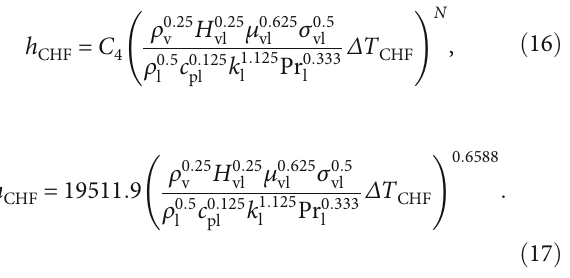
LFP by Equation